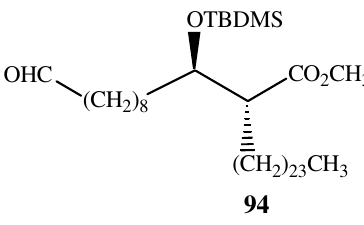
FIGURE 7. Structure of β -hydroxy- α -alkyl fatty acid 94